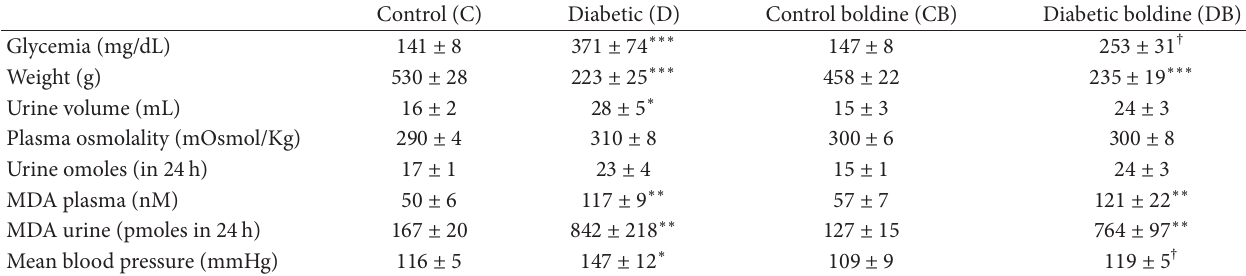
Table 1: Pathophysiological status of experimental animals.